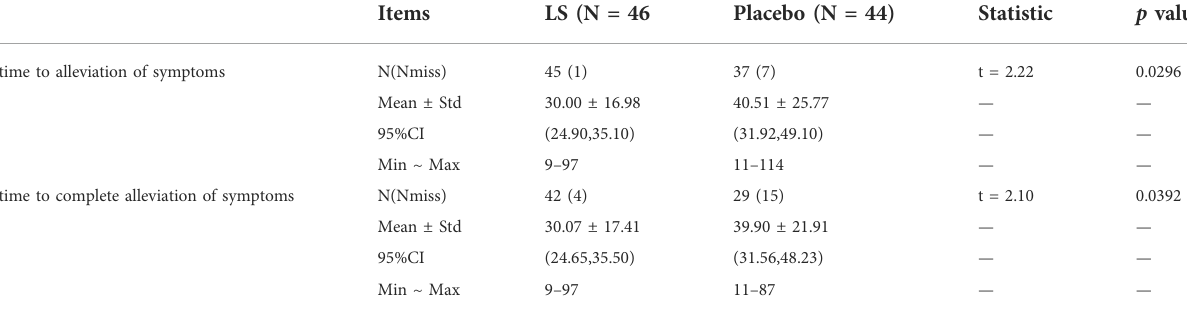
TABLE 5 The remission time and complete remission time of symptoms in LS and Placebo group